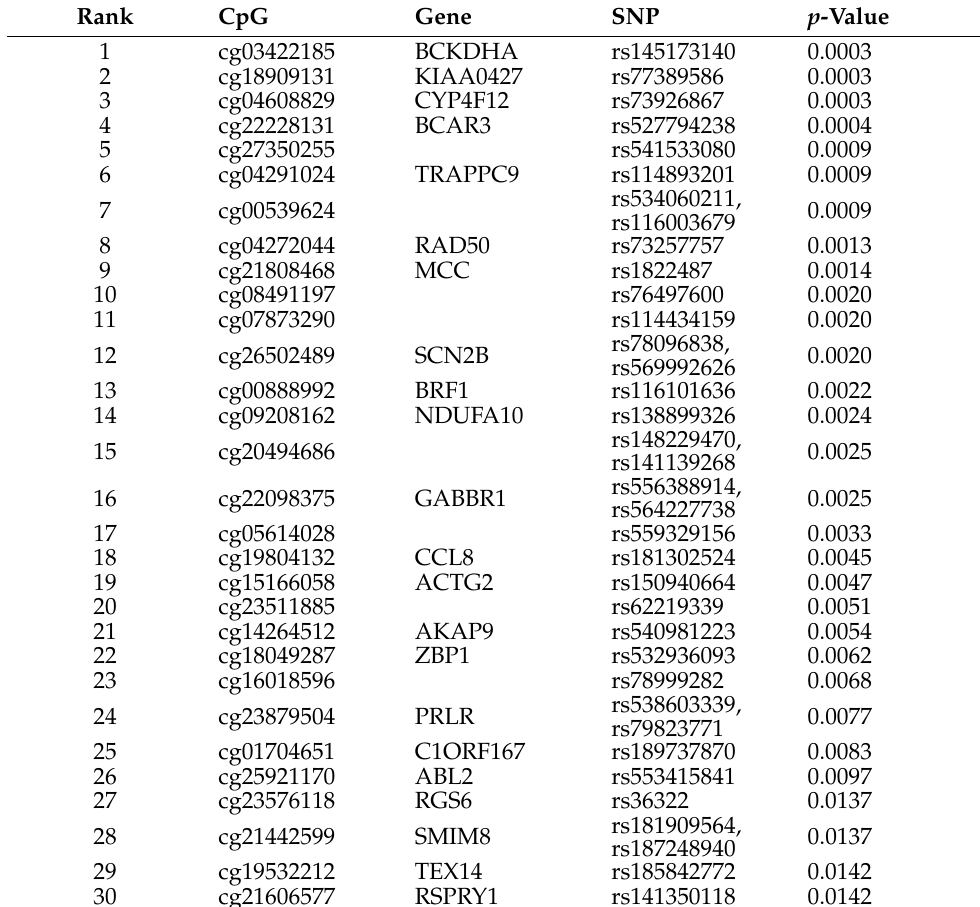
Table 3. Top 30 polymorphic CpGs associated with HbA1c